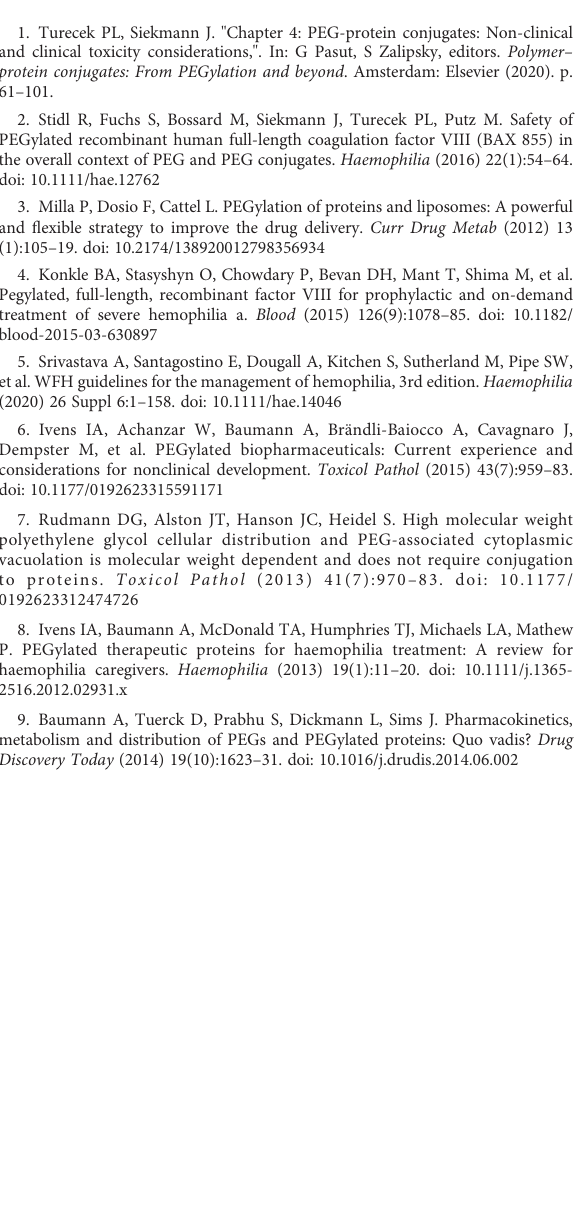
dashed = stage (B) : > 3 small vacuoles or at least one big vacuole ( ≈ 5% of cell caliber) in a single MDM; blue solid = stage (C) : vacuolation of ≥ 75% of cell volume. The table below summarizes the statistics for this picture. SUPPLEMENTARY FIGURE 2 Effect of 20-kDa PEG exposure on basal cytokine secretion by human MDMs. Cytokines IL-10, IL-12p70, IL-1 b and IL-6 produced by resting MDMs after 24 hours of PEG exposure (n = 5). Data shown as individual values, with the horizontal line indicating the median. ns, not signi fi cant (one-way ANOVA/Friedman ’ s test; post-hoc test: Dunn ’ s multiple comparison). Some values from donors were under detection limit and could therefore not be plotted. ANOVA, analysis of variance; IL, interleukin; LPS, lipopolysaccharide; MDM, monocyte-derived macrophage; PEG, polyethylene